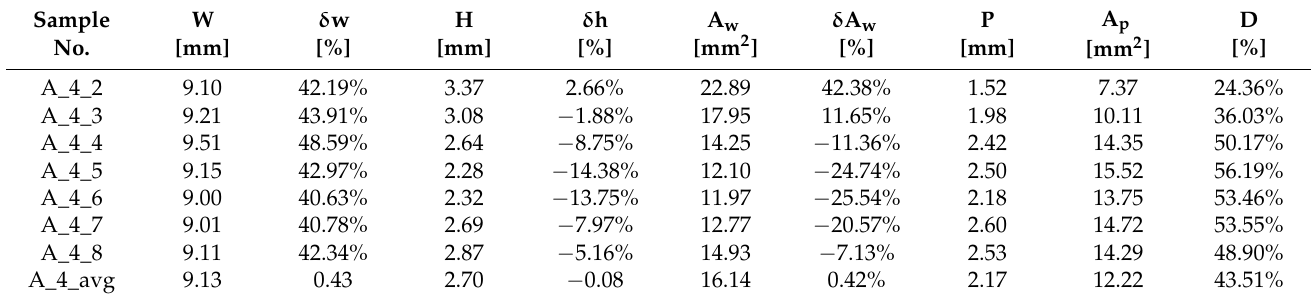
Table A5. Measurements of dimensional features of 5th parameter set of Wire A—wire feed